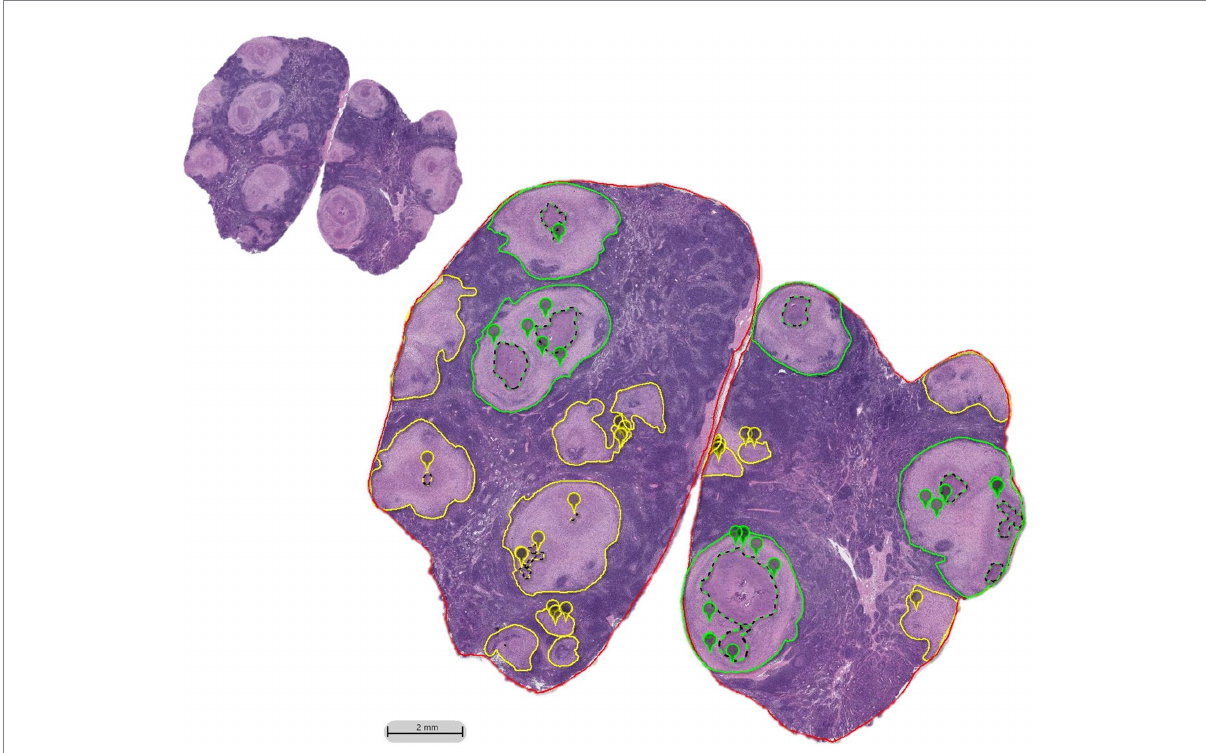
FIGURE 1 HALO imaging annotations performed on H&E tracehobronchial lymph node sections of BCG-vaccinated and non-vaccinated cattle challenged with aerosolized M. bovis . Granulomas were outlined in either green or yellow based on the amount of necrosis and/or if their boundaries were indistinguishable from the neighboring granuloma (coalescing). If there was ≤ 10% necrosis, it was classified as a low-grade granuloma and outlined in yellow. If there was >10% necrosis or if it was a collection of coalescing granulomas, it was outlined in green and categorized as high- grade. Necrosis, when present, was outlined by a dotted line of a matching color. MNGCs identified at 10X were marked with a pin of the same color as the grade designation. H&E section prior to annotation shown in